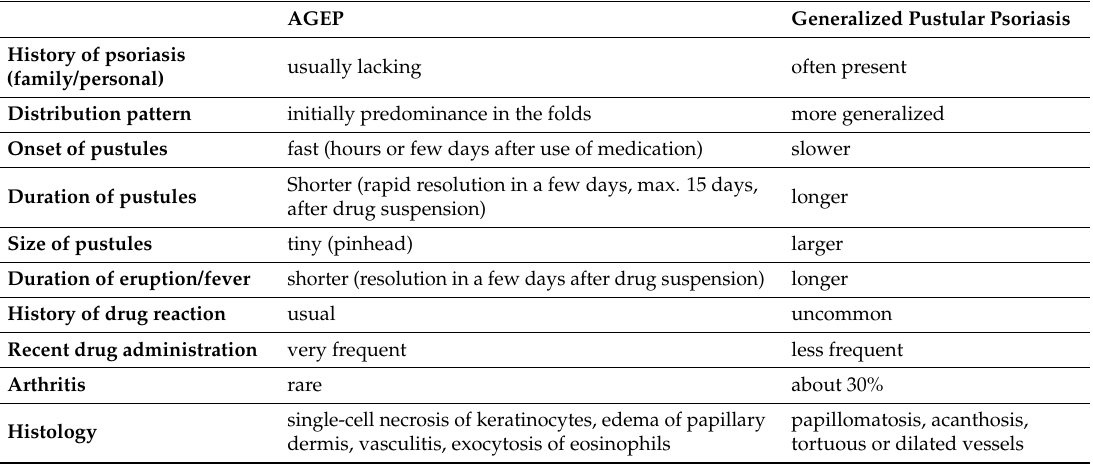
Table 1. Factors favoring the diagnosis of AGEP over pustular psoriasis.